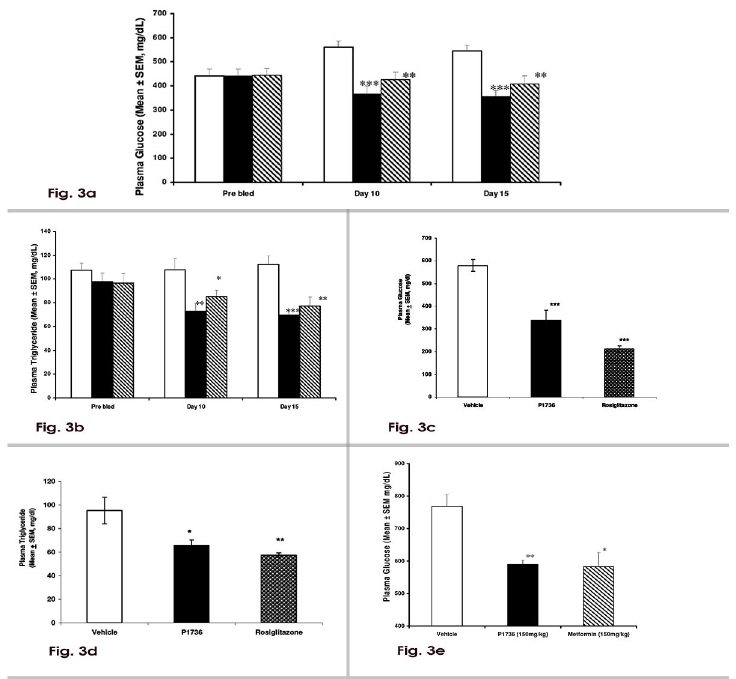
Figure 3. P1736 reduces circulating glucose and triglyceride levels in diabetic db/db mice. a , Plasma glucose levels in male db/db mice that received once daily oral doses of vehicle(empty bar) or P1736 (150 mg/kg, solid bar) or metformin (150 mg/kg, bar with stripes) for 15 days. b , Plasma triglyceride levels of db/db mice that received vehicle(empty bar) or P1736 (150 mg/kg, solid bar) or metformin (150 mg/kg, bar with stripes) for 15 days. c , Plasma glucose and d , Plasma triglyceride levels of male db/db mice that received vehicle(empty bar) or P1736 (5 mg/kg twice daily, solid bars) or equal dose of rosiglitazone (bar with dots). e , Plasma glucose levels of male db/db mice with high initial plasma glucose, that received vehicle(empty bar) orP1736 (150 mg/kg once daily, solid bar) or metformin (150 mg/kg once daily, bar with stripes) for 10 days. Data are expressed as Mean ± SEM for 7 - 10 animals per treatment group. Differences between vehicle and compound treated groups were statistically evaluated by t-test. *p<0.05, **p<0.01, ***p<0.001